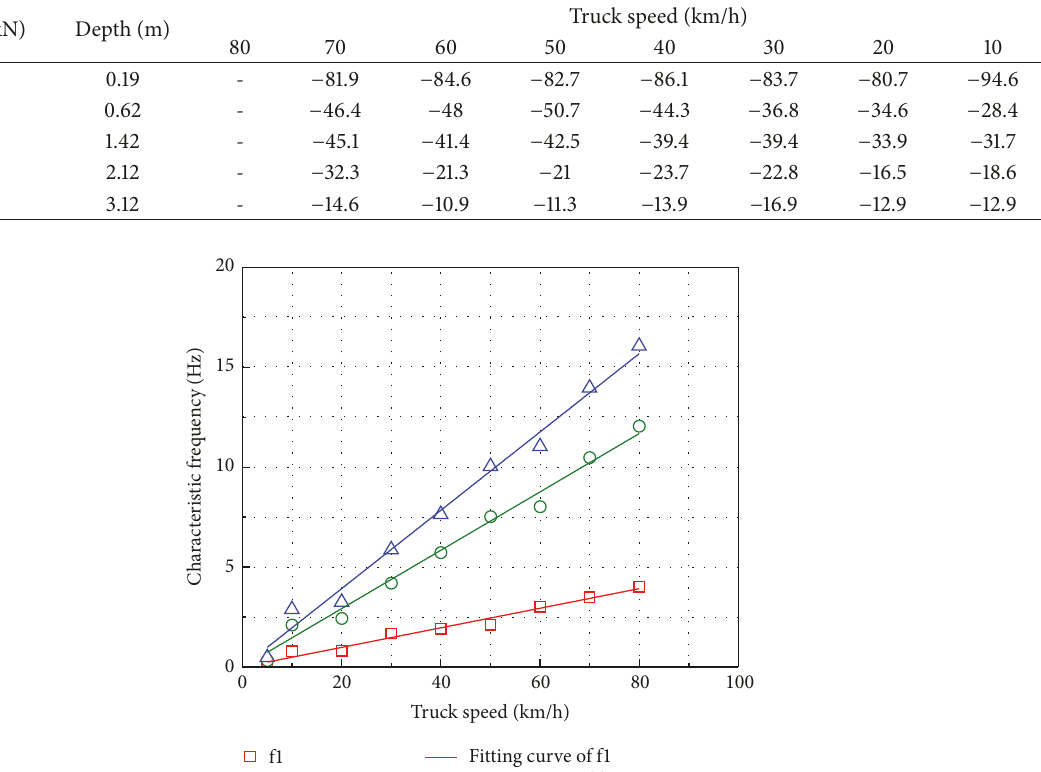
Table 4: Maximum dynamic stresses under different truck loadings.